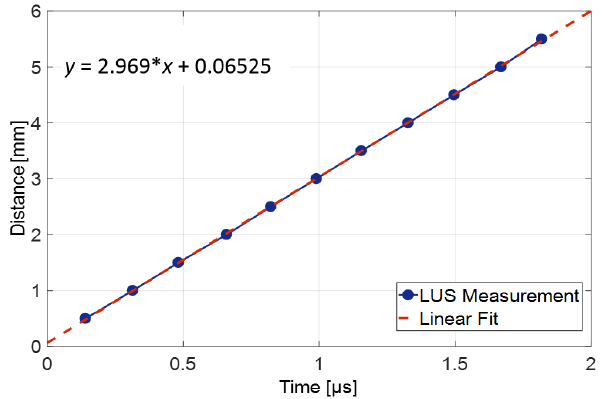
Figure 5. LUS measurement on bulk aluminium. Comparison of EFIT result to LUS measurement.